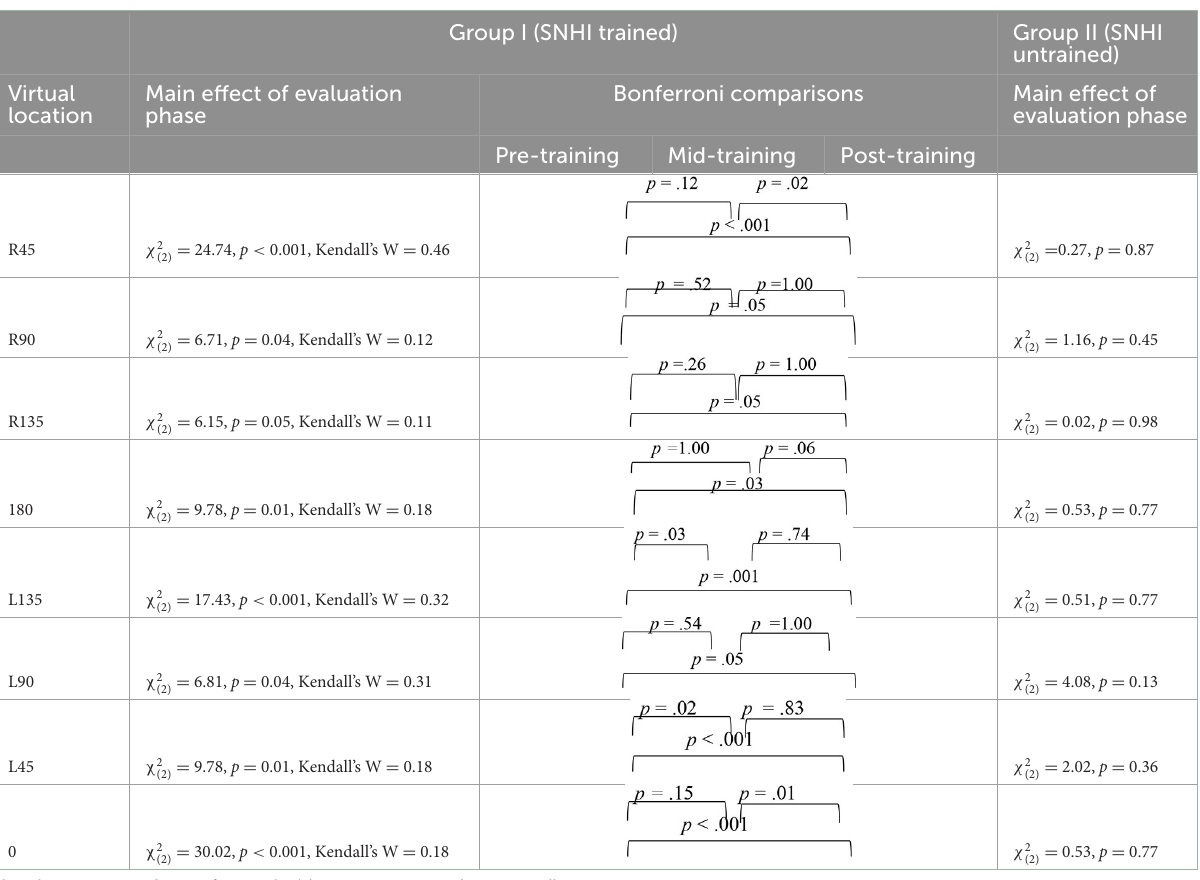
TABLE 2 Results of Friedman test for main effect of evaluation phase and follow-up adjusted Bonferroni’s pairwise comparisons for SNHI-trained and SNHI-untrained groups at each virtual location in VASI test.